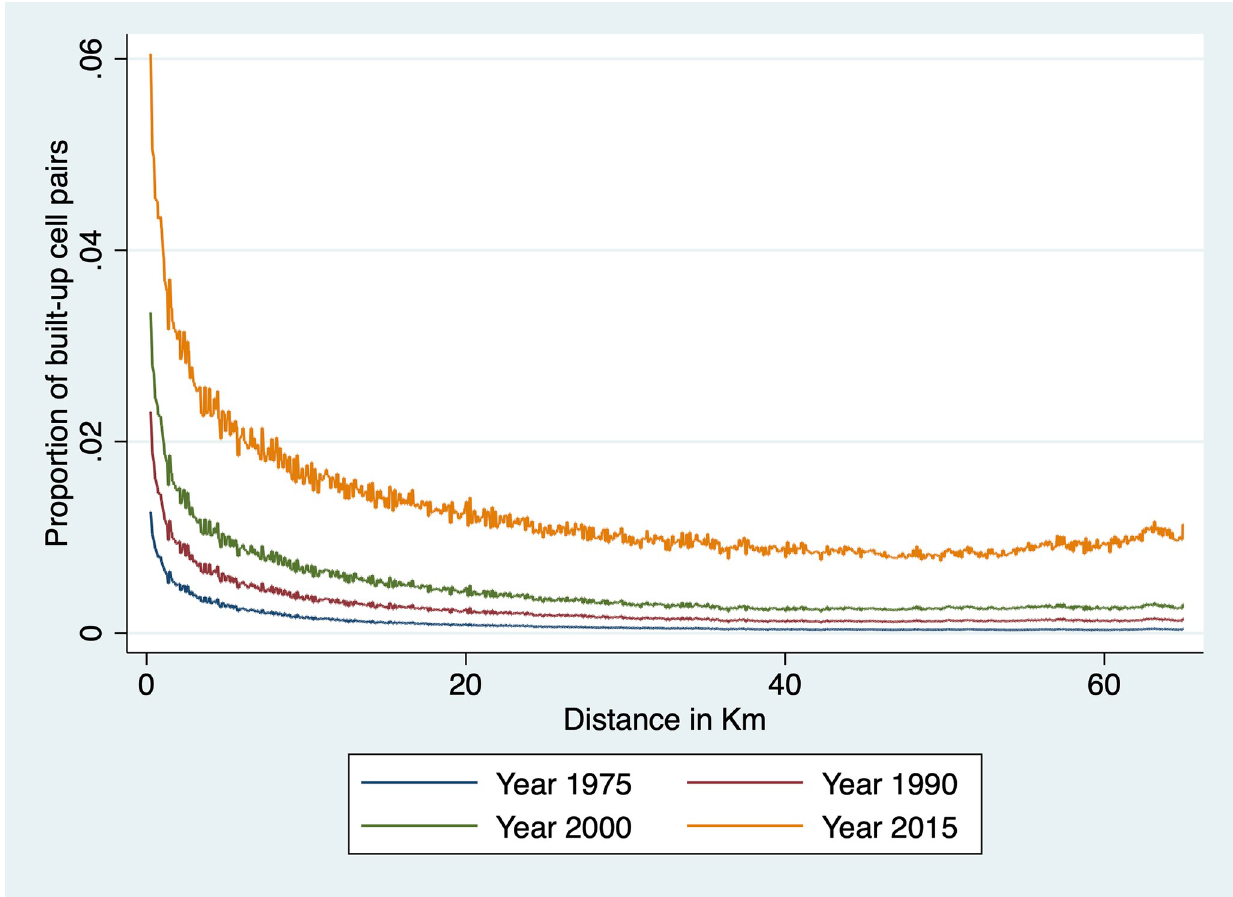
Fig 13. Figs 13 and 14 show, for each distance value within big tiles, the proportion of cell pairs that are both built-up. For instance, a value of 2% at distance 4Km means that pairs with two built-up cells make up 2% of all the cell pairs distant from each other by 4Km. Four correlograms are displayed, one for each of the years for which we have buildup data. The two Figures are constructed in the same way, except that Fig 14 only includes cell pairs in which both cells are near a road, either in the cell itself or in a neighboring cell n 1 or n 2 . Confidence intervals are not shown because they are too tight to be visible in the